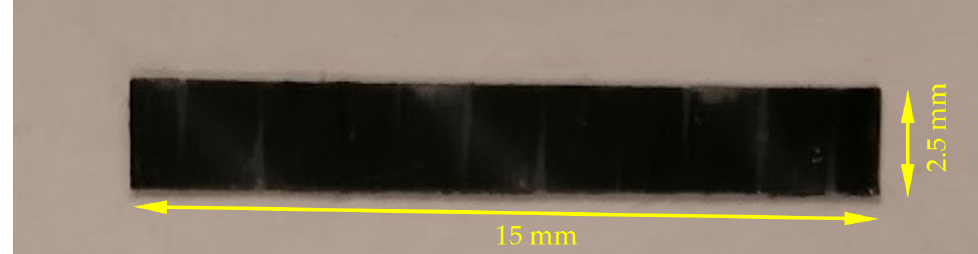
Figure 2. The tensile SHPB test specimen of T700/PA6.6.